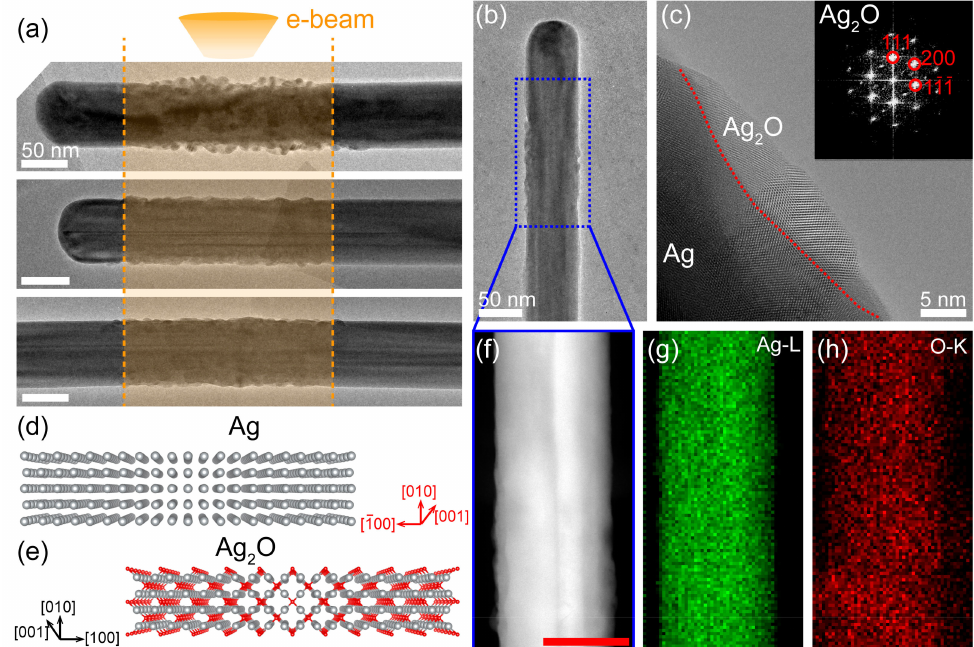
Figure 1. Oxidation of Ag nanowires triggered by electron beam. ( a ) Morphology changes only occur in the regions exposed to the electron beam. ( b ) TEM image of Ag nanowire. The blue dotted lines highlight the oxidation area. ( c ) High resolution TEM image of the oxidation area. The red dotted line shows the interface of Ag and Ag 2 O; the inset is the fast Fourier transform (FFT) pattern of Ag 2 O crystal. ( d , e ) Atomic structures of Ag and Ag 2 O, respectively. Red and gray balls represent the O atoms and Ag atoms, respectively. ( f – h ) HAADF-STEM image and EDS elemental maps of the oxidation area in ( b ). Scale bars for ( a , b , f ) at 50 nm, for ( c ) at 5 nm.